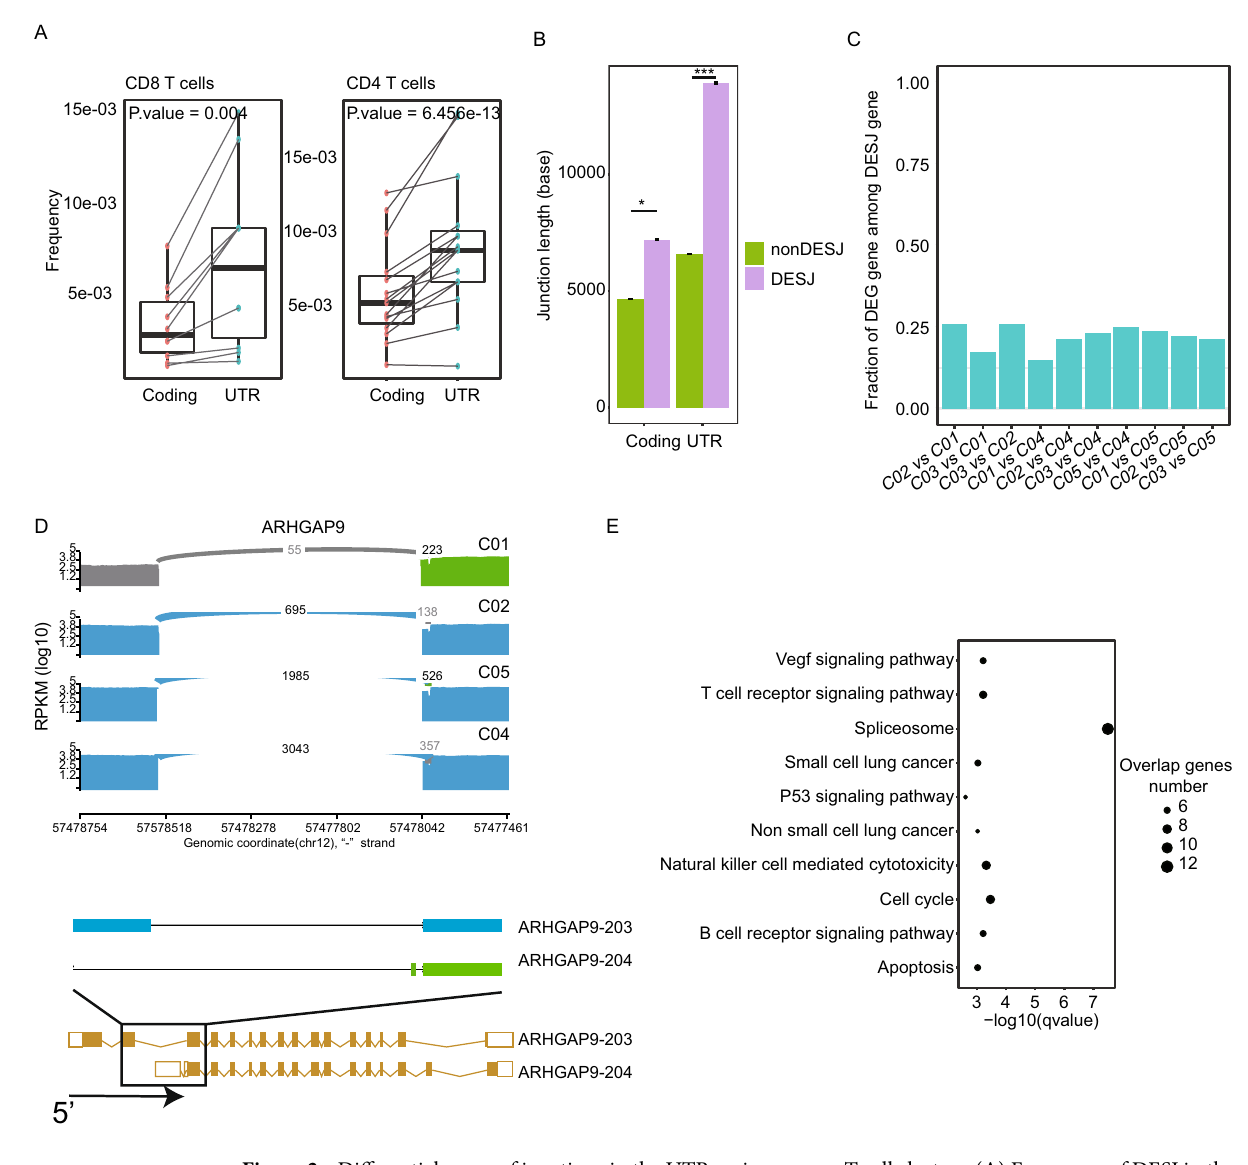
Figure 2. Differential usage of junctions in the UTR regions across T cell clusters. ( A ) Frequency of DESJ in the UTR regions is significantly higher than in the coding regions. These points represent T cell clusters. ( B ) Length difference between DESJ and non-DESJ in the coding region and the UTR region. ( C ) A bar plot depicting the fraction of DEG genes among DAS genes across CD8 + T cells. ( D ) Sashimi plots illustrating the read distribution of ARHGAP9 in CD8 + T cells from P0508. The colors represent different isoforms. This alternative splicing of ARHGAP9 happens in the 5 ′ UTR regions. Naïve T cells (C01_CD8.LEF1) show obvious differential usage of isoforms compared to other clusters. ( E ) Results of KEGG pathway analysis of genes with differential splicing in the UTR